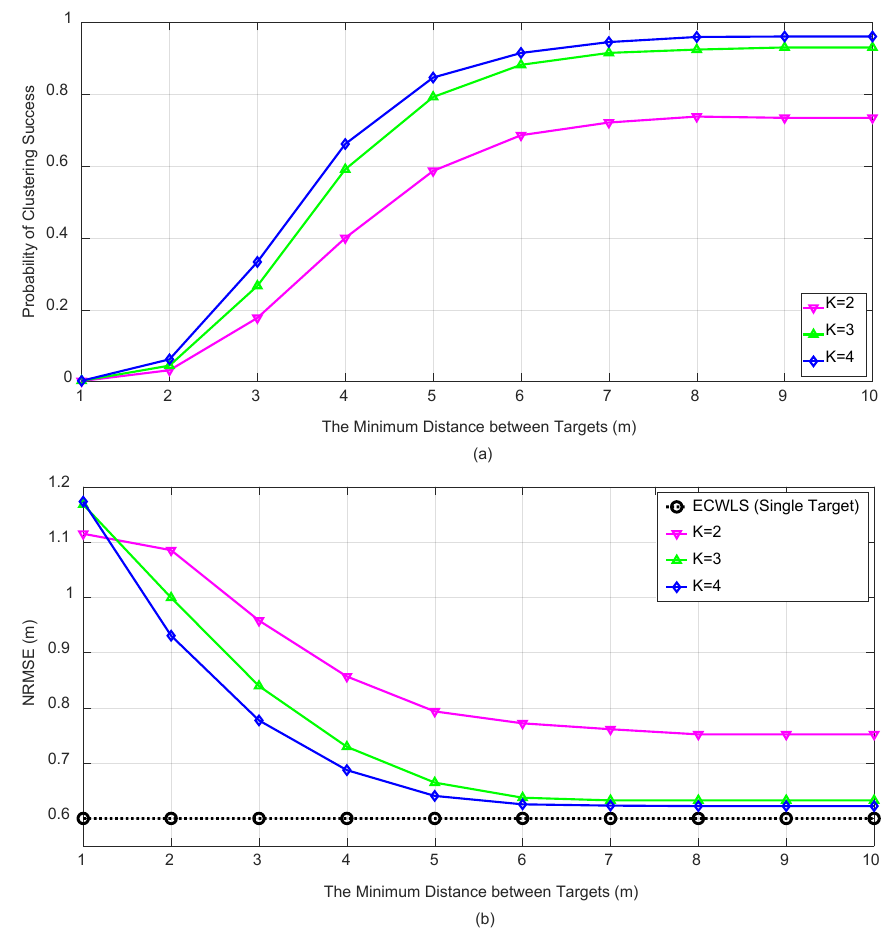
Figure 7. PCS ( a ) NRMSE ( b ) vs. within-target distance for N = 6 under σ w = σ v = 5 (deg). σ u im im